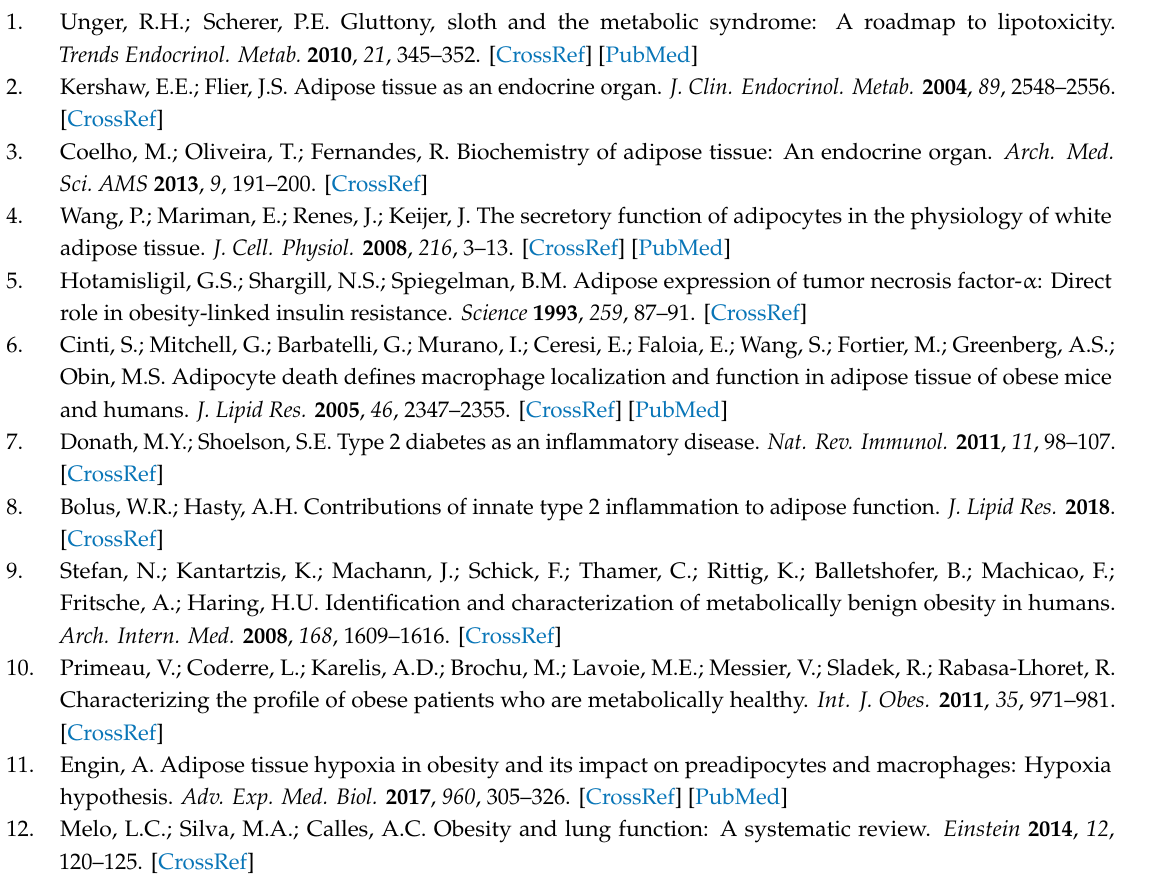
Table S1: Diet composition, Table S2: Primers and annealing temperature for RT-qPCR, Table S3: Marker gene expression for adipogenesis-, angiogenesis-, hypoxia-, and inflammation-related processes, Table S4: Genes downregulated by OxR with an absolute fold change > 1.25 and p < 0.01, Table S5: Genes up regulated by OxR with a fold change > 1.25 and p <